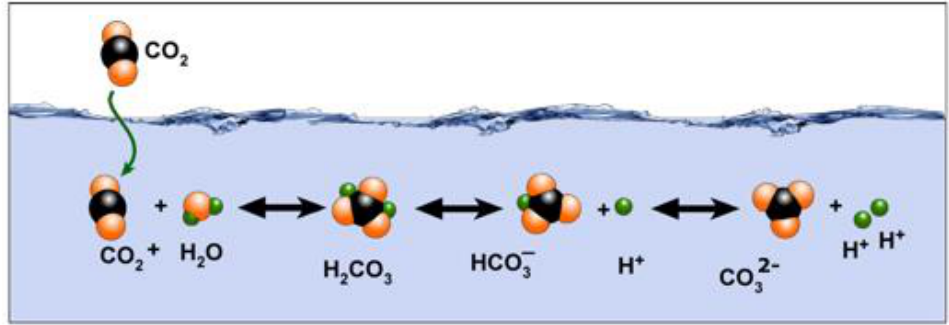
Figure 3. In an aqueous solution, carbonate, bicarbonate, carbon dioxide, and carbonic acid exist together in dynamic equilibrium, e.g., [10,20]. When CO 2 is absorbed by seawater, a series of chemical reactions increase the concentration of H + and cause the seawater acidity to increase. When calcium carbonate (e.g., limestone) reacts with acidic free hydrogen (H + ) ions in seawater, the solid calcium carbonate dissolves, releasing free calcium (Ca 2+ ) ions and free bicarbonate (HCO 3 – ) ions. (This figure is an original interpretation by L. Pomar based on numerous sources).